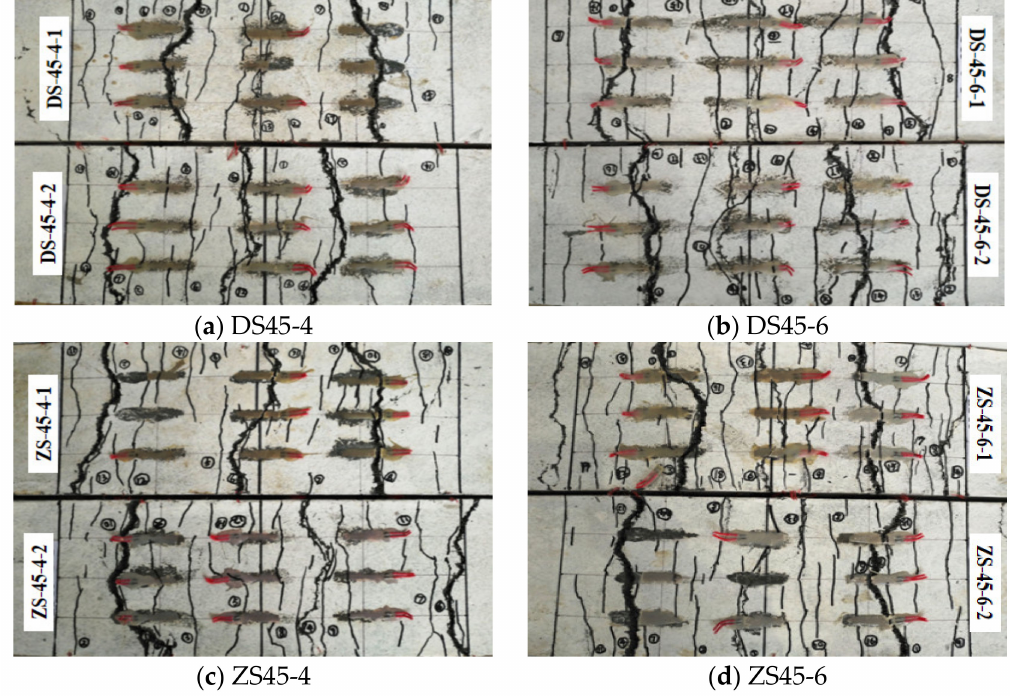
Figure 15. Distribution of cracks in pure-negative-bending-moment